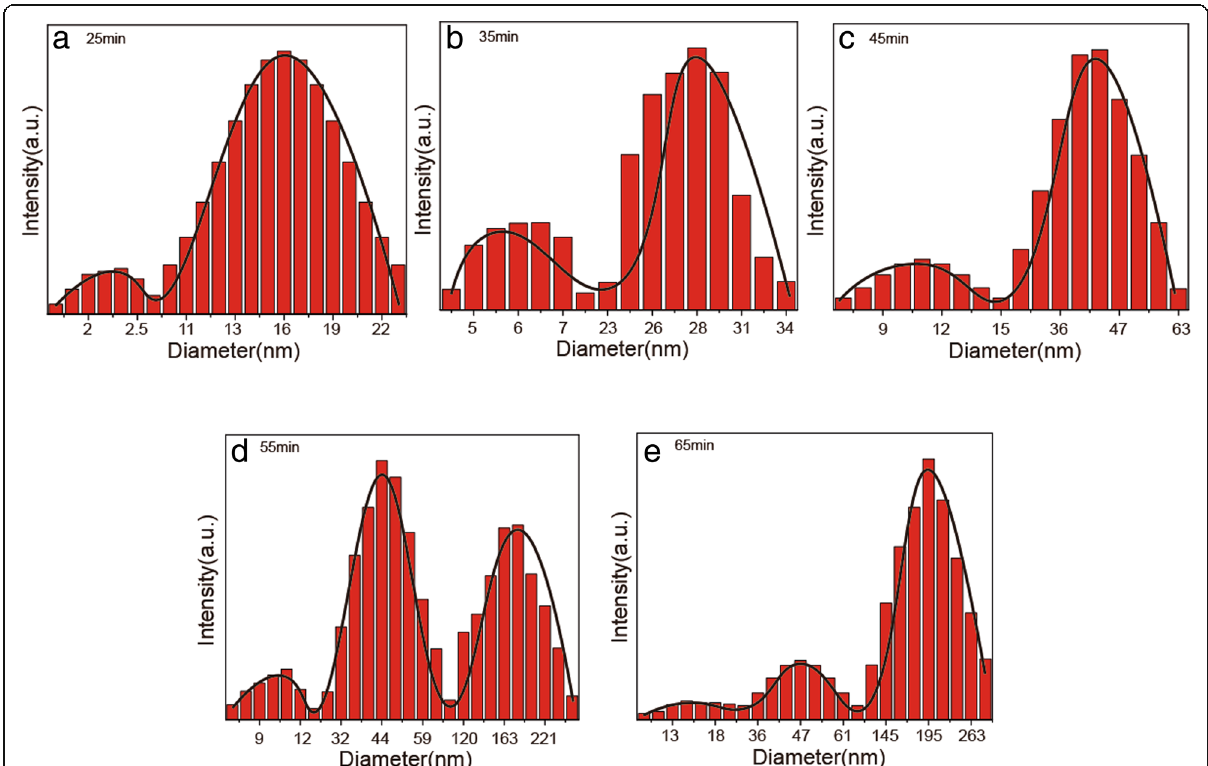
Fig. 7 Particle size distribution of samples obtained at 55 °C, with 7.46 mmol and 0.1 mol of NaOH and zinc acetate dihydrate initial concentrations, respectively, and for a 25 min, b 35 min, c 45 min, d 55 min, and e 65